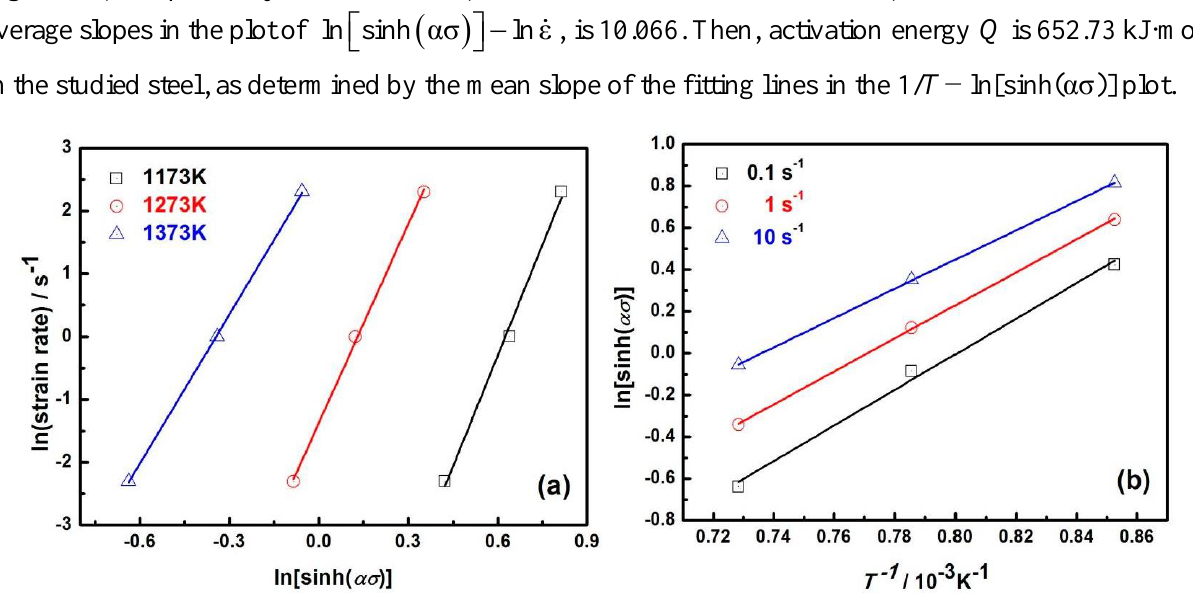
Figure 3. Relationships between ( a ) ln[sinh(ασ)] and ln ε at different deformation temperatures; ( b ) T −1 and ln[sinh(ασ)] at different strain rates.